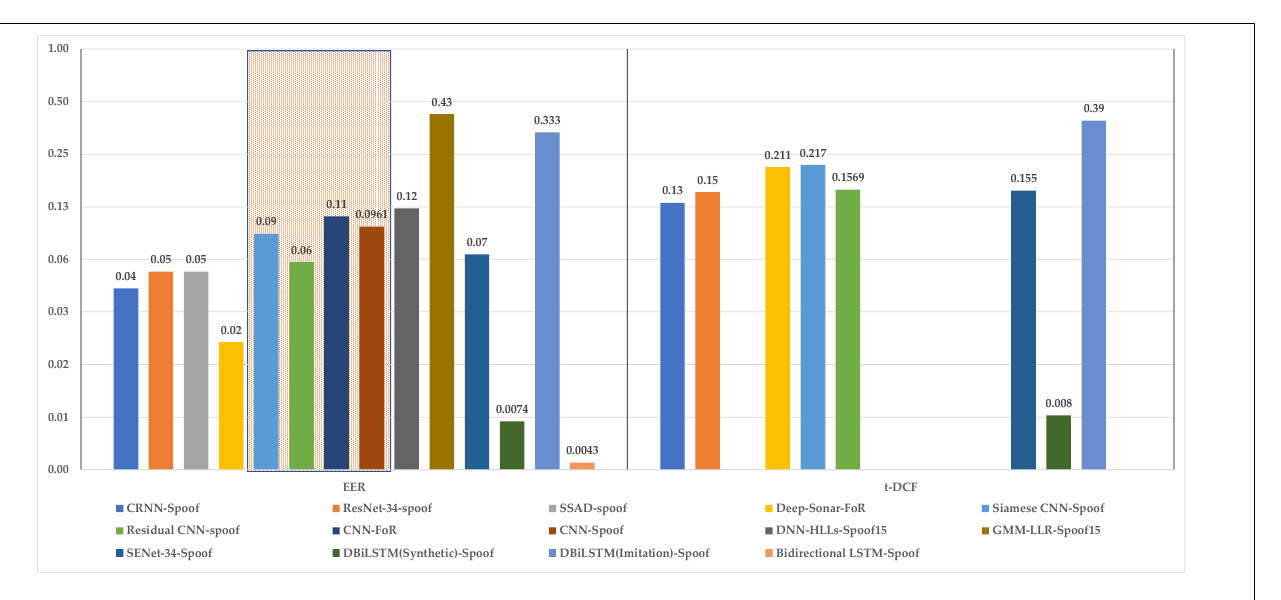
Figure 5. Quantitative comparison of AD detection methods measured by EER and t-DCF.